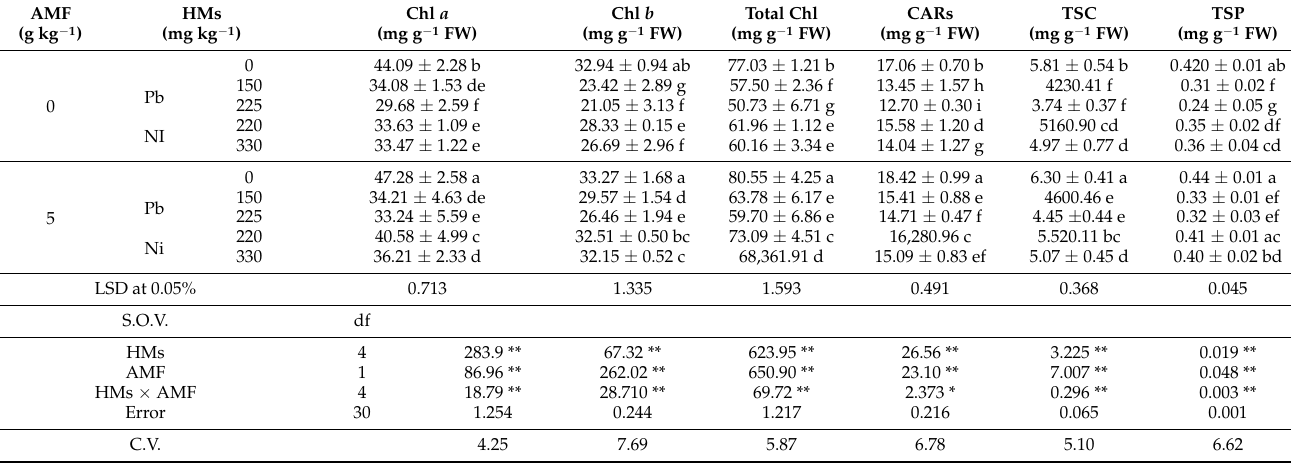
Table 3. The effects of arbuscular mycorrhiza fungi (AMF) inoculation on the content of photosyn- thetic pigments, total soluble carbohydrates (TSC), and total soluble proteins (TSP) of lavender plants under Pb and Ni